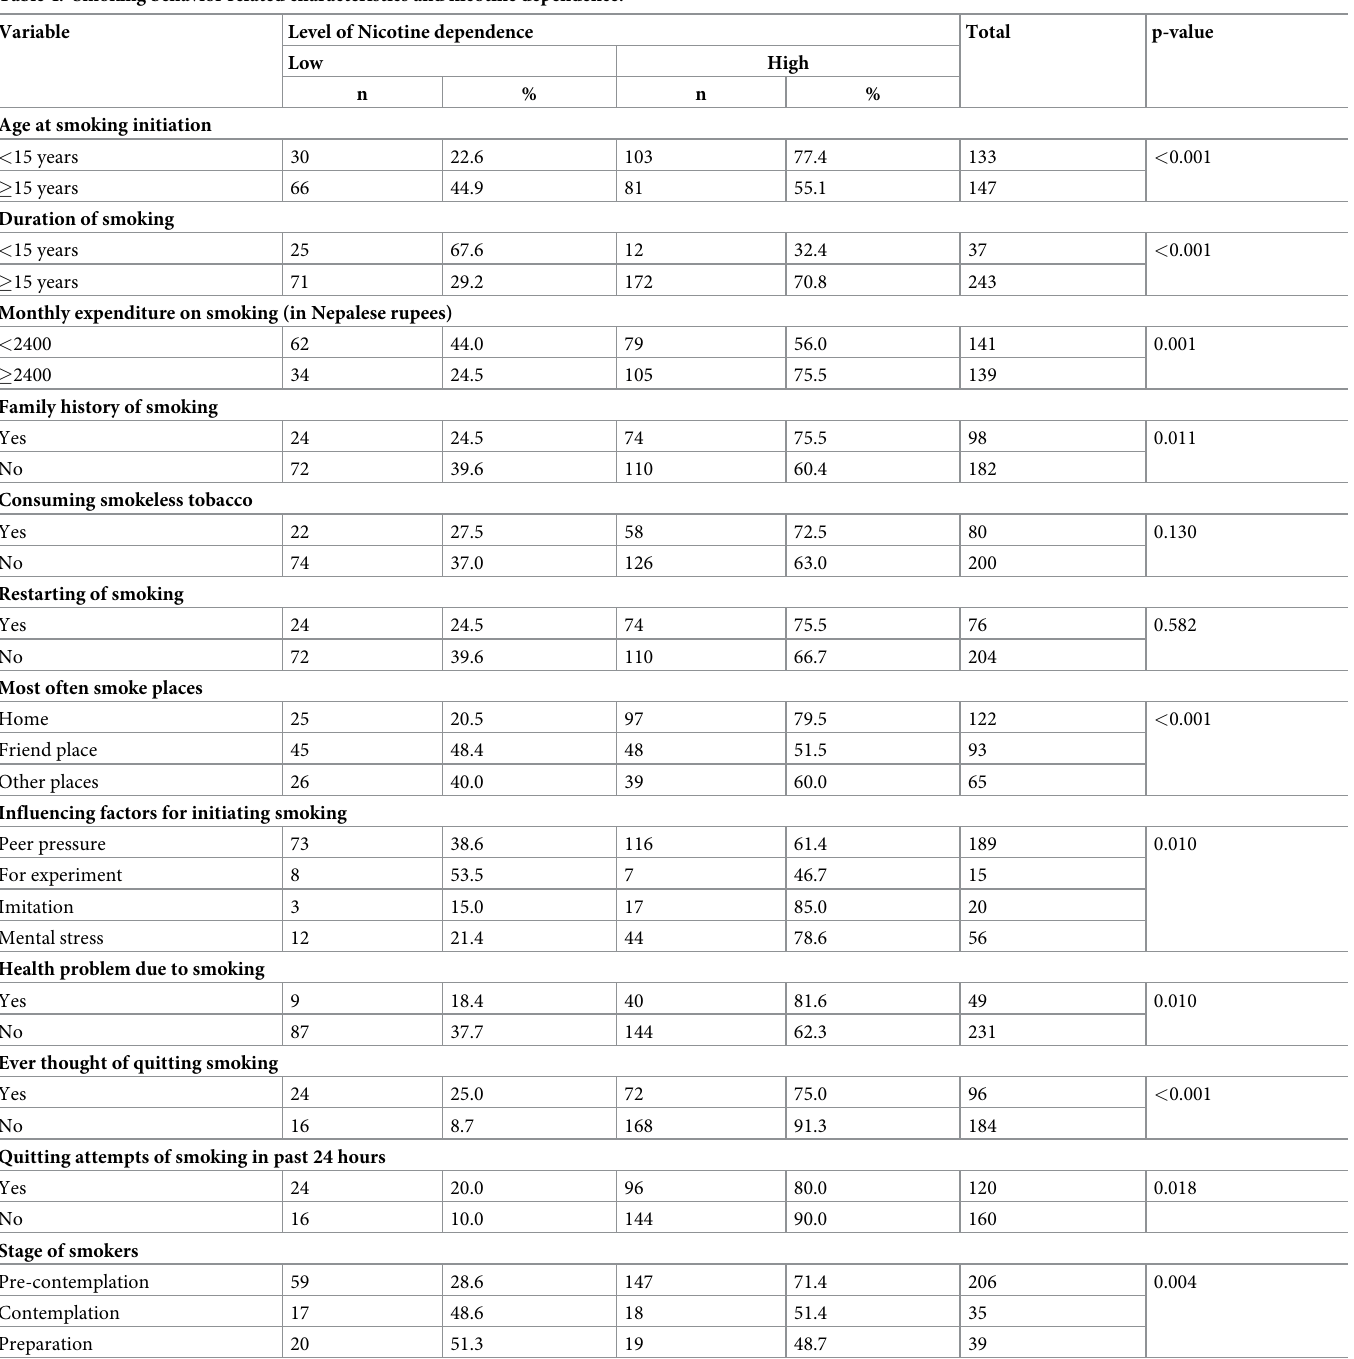
Table 4. Smoking behavior related characteristics and nicotine